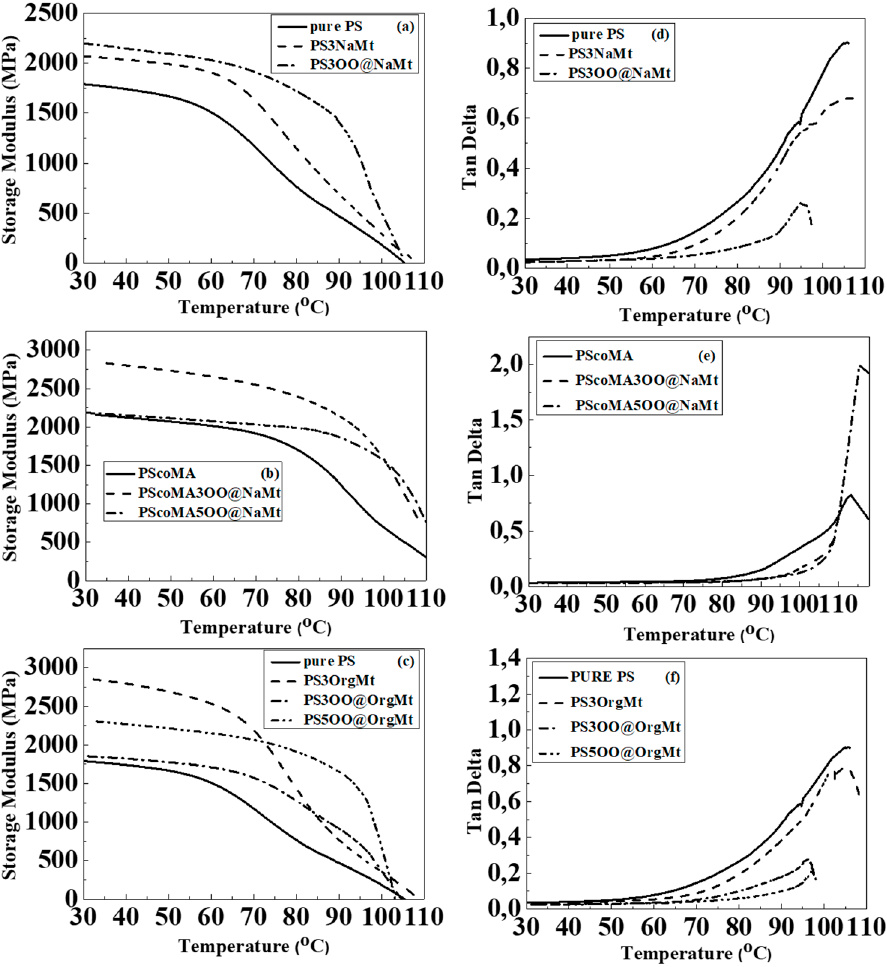
Figure 5. Left part: Storage modulus of ( a ) pure PS, PS3NaMt and PS3OO@NaMt, ( b ) PScoMA, Figure 5.